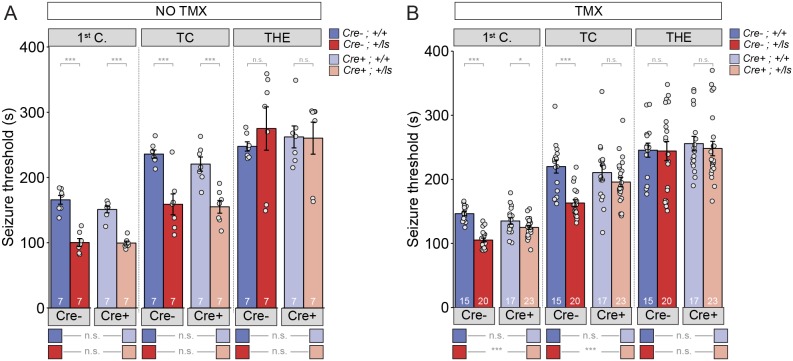
Seizure threshold is improved after adult restoration of SynGAP expression.(A) SyngapCre-;+/ls and SyngapCre+;+/ls mice exhibit hyperexcitability in two of the three events without Cre activation (No TMX) Main effects-1st clonus: Cre F(1,24)=2.13, p=0.157, Genotype F = 117.73, p=9.75E-11, Interaction F(1,24)=1.69, p=0.206); Cre- Cohen’s d = 3.855, Cre +Cohen’s d = 4.737. TC: Cre F(1,24)=722, p=0.404, Genotype F(1,24)=40.05, p=1.53E-6), Interaction F(1,24)=.257, p=0.617); Cre- Cohen’s d = 2.396, Cre+ Cohen’s d = 2.405. THE: Cre F(1,24)=9.99E-6, p=0.998, Genotype F(1,24)=.320, p=0.577), Interaction F(1,24)=.420, p=0.523. (B) SyngapCre+;+/ls mice exhibit thresholds comparable to those of SyngapCre-;+/ls mice after Cre activation (TMX-treated) in two of the three events Main effects-1st clonus: Cre F(1,71)=2.59, p=0.112; Genotype F(1,71)=58.328, p=7.86E-11, Interaction F = 1 (1,71)=18.84 p=4.62E-5; Cre- Cohen’s d = 3.329, Cre+ Cohen’s d = 0.674; TC: Cre F(1,71)=4.53, p=0.037, Genotype F(1,71)=26.15, p=2.57E-6, Interaction F(1,71)=6.50, p=0.013; Cre- Cohen’s d = 2.040; Cre+ Cohen's d = 0.540; THE: Cre F(1,71)=.037, p=0.847, Genotype F(1,71)=1.15E-5, p=0.997, Interaction F(1,71)=.049, p=0.826. Data points (and numbers) in bars represent biological replicates (animals). Data from panel B are pooled from two separate experiments.10.7554/eLife.46752.005Figure 1—source data 1.Source data for Figure 1A.10.7554/eLife.46752.006Figure 1—source data 2.Source data for Figure 1B.